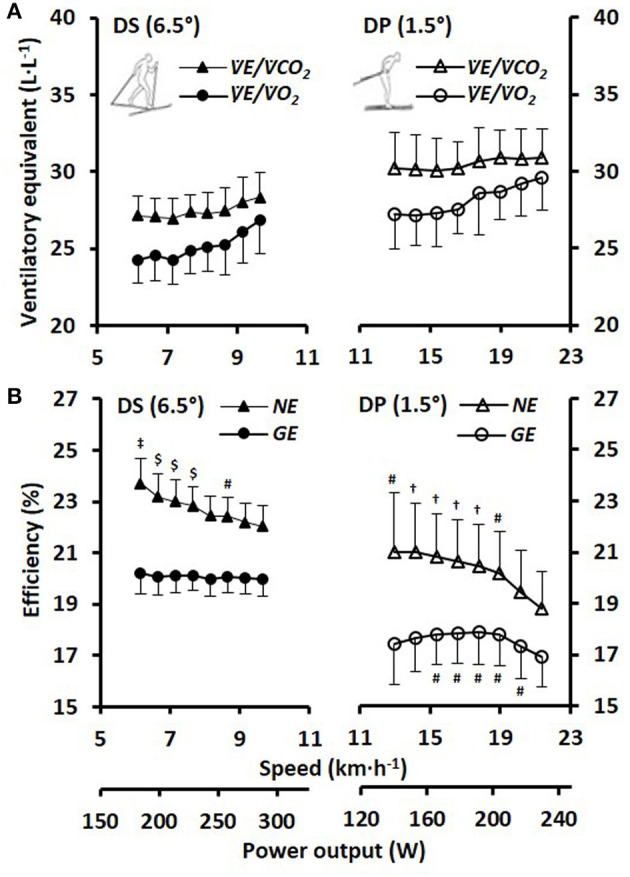
(A) Ventilatory equivalents of oxygen (VE.·V.O2-1) and carbon dioxide (VE.·V.CO2-1) and (B) net efficiency (NE) and gross efficiency (GE) for the respective sub-techniques plotted against skiing speed and the average power output for the eight 4-min stages of submaximal treadmill roller-skiing (SUB1−8) with diagonal stride (DS) and double poling (DP) at inclines of 6.5 and 1.5°, respectively. The values are presented as mean ± SD. Statistical comparisons were performed for GE and NE.‡Statistically significantly different (SSD) from SUB4−8. $SSD from SUB5−8. †SSD from SUB7−8. # SSD from SUB8.